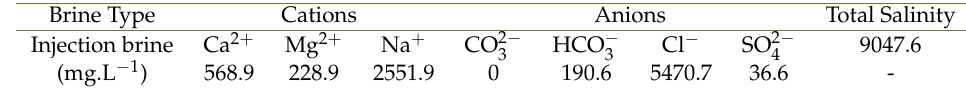
Table 1. Composition of the simulated injection